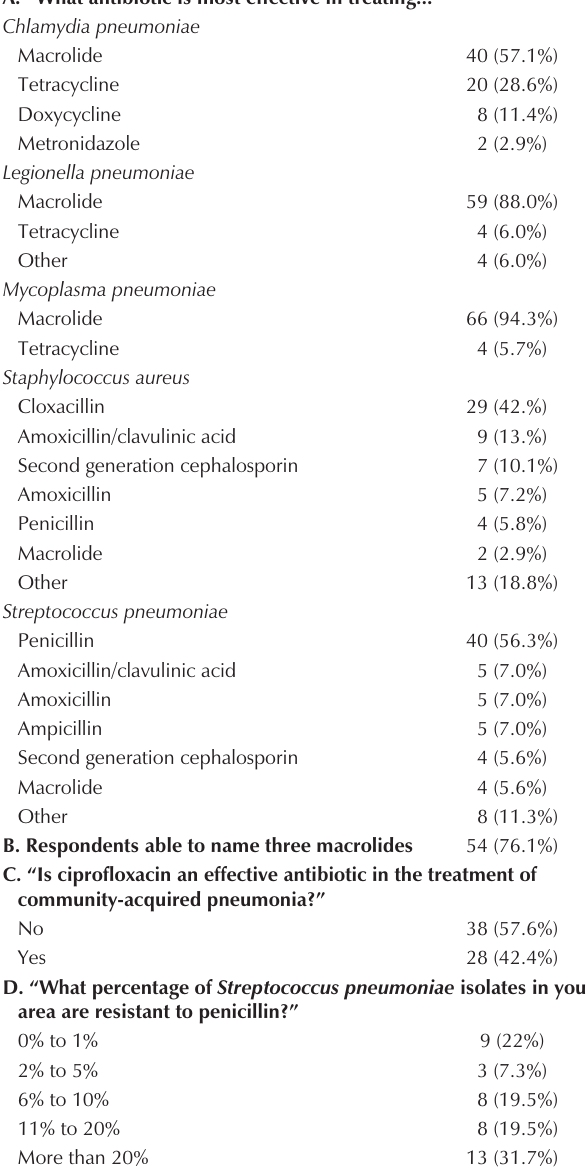
Answers to knowledge-testing questions on case-based questionnaires regarding antibiotic choice to treat community acquired pneumonia (n=71)